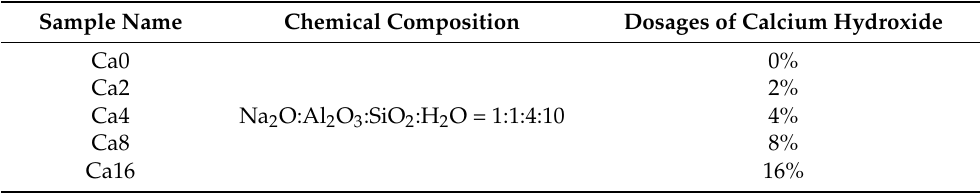
Table 1. Mix formulation of metakaolin-based geopolymers containing calcium hydroxide. Calcium hydroxide was added from 0% to 16% of the total mix